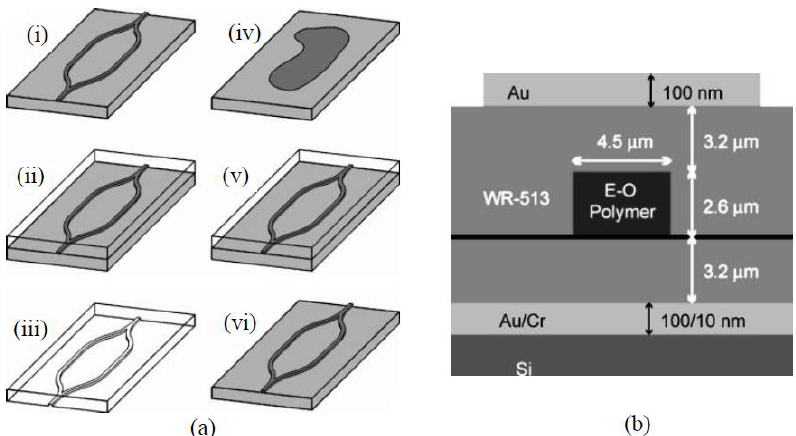
Figure 23. ( a ) Fabrication of the PDMS mold (i–iii) and replication of the MZI structure (iv–vi). A